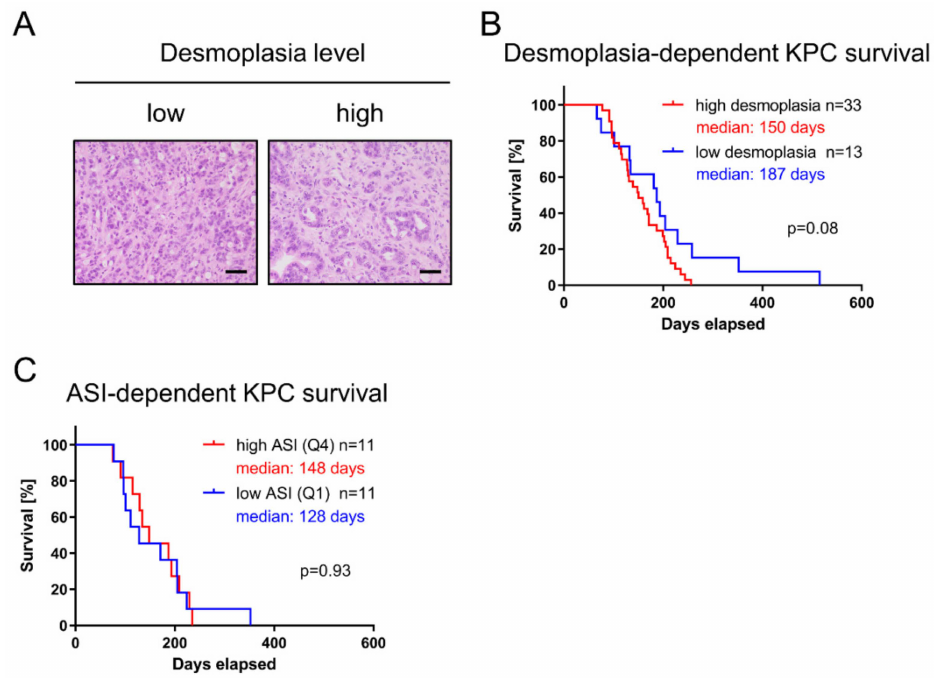
Figure 6. Desmoplasia and fibroblast activation not correlated to KPC survival. ( A ) Hematoxylin and eosin (H&E) staining revealed heterogeneity in desmoplasia despite equal grading (G2). ( B ) H&E staining graded according to extent of tumor stroma. ( C ) Activated stroma index (ASI) calculated from the ratio of α -SMA positive area and collagen positive area and subdivided into